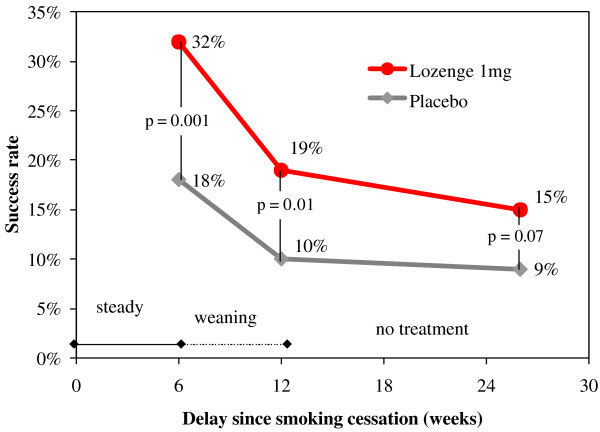
Smoking cessation success rates among users of 1 mg nicotine lozenges (moderately dependent patients) (adopted from [17]). The rate of fully (no cigarettes) or partially (≤ 1 cigarette/day and ≤ 7 cigarettes/week) abstinent subjects using 1 mg nicotine lozenges for abrupt quitting over the first 6 months of the French efficacy trial.